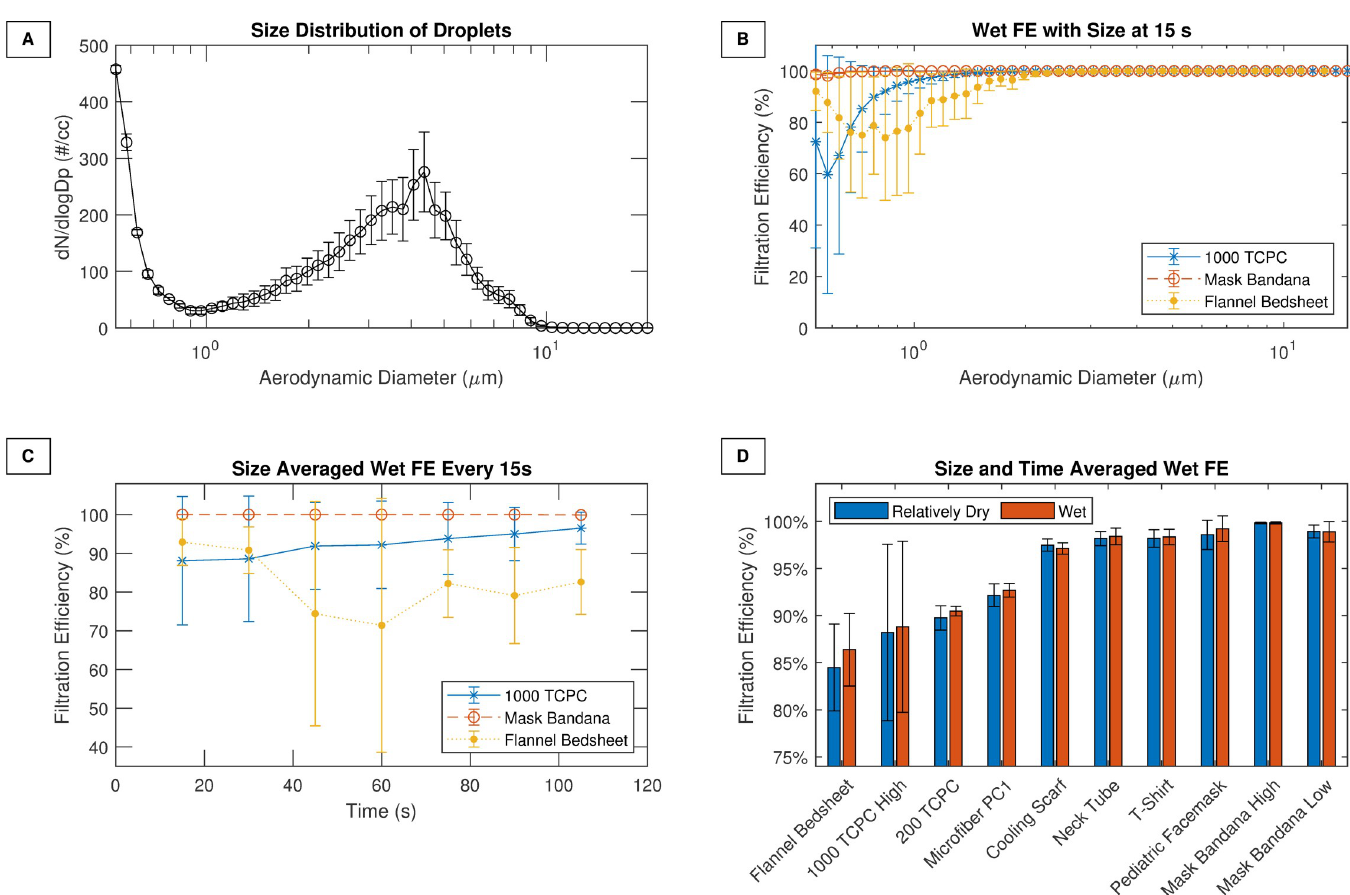
Fig 2. Fabric performance against droplets. (A) Size distribution of the droplets generated for wet FE experiments. (B) FE as a function of size for three fabrics during first 15–30 seconds. (C) The size-based FE averaged over the entire size range and plotted for each scan interval from 15 s to 120 s for the same materials. (D) The time- averaged and size-averaged droplet filtration efficiency for various materials. A medical grade facemask was also used as a control. TC: Thread count; PC: Pillow case. High–represents high velocity (~ 1700 cm/s).